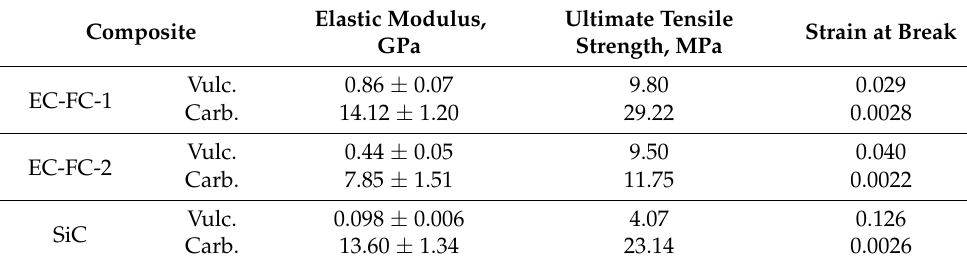
Figure 1. Experimental stress–strain curves with indicated 95% confidence interval for ( a ) vulcanized and ( b ) carbonized specimens that were tested at a constant crosshead speed of 0.2 mm/min. The appearance of broken samples is shown in the lower row of images. Table 1. Mechanical properties of CECs.